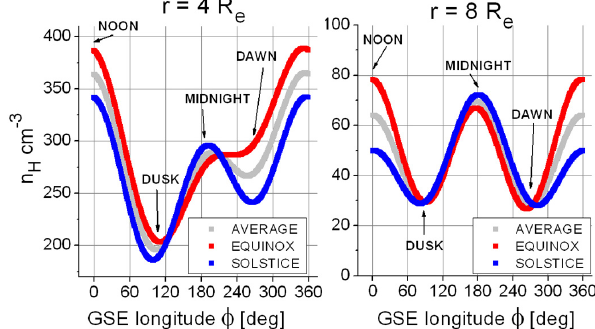
Fig. 9. Longitudinal H-density profiles for φ =0 ◦ -360 ◦ at 4 R E (left) and 8 R E (right) geocentric distance separate for the summer- solstice- (blue), equinox- (red) and seasonal-averaged (gray) model